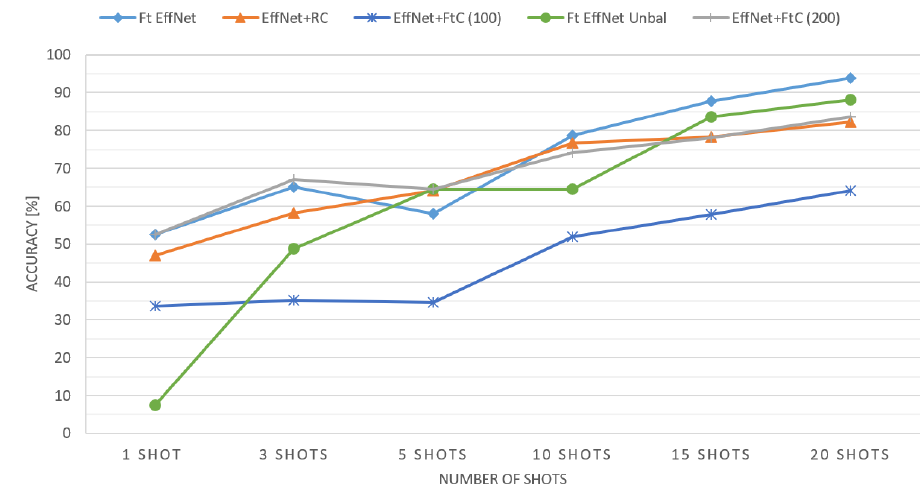
Figure 8. The accuracy of the different classification models for new classes. Ft EffNet: fine-tuned EfficienNet-B7; EffNet+RC: fixed EfficienNet-B7 backbone plus randomized classifier; EffNet+FtC: fixed EfficienNet-B7 backbone plus fine-tuned classifier; Ft EffNet Unbal: fine-tuned EfficienNet-B7 with unbalanced